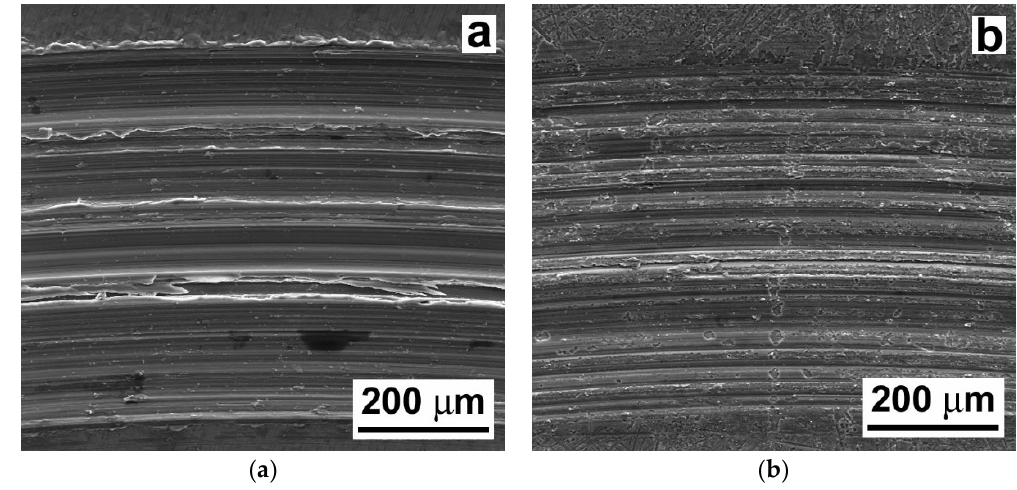
Figure 9. Scanning electron microscope (SEM) images showing the morphological characteristics of the wear tracks in the AZ61 base material: ( a ) the laser untreated and ( b ) the laser treated material state.